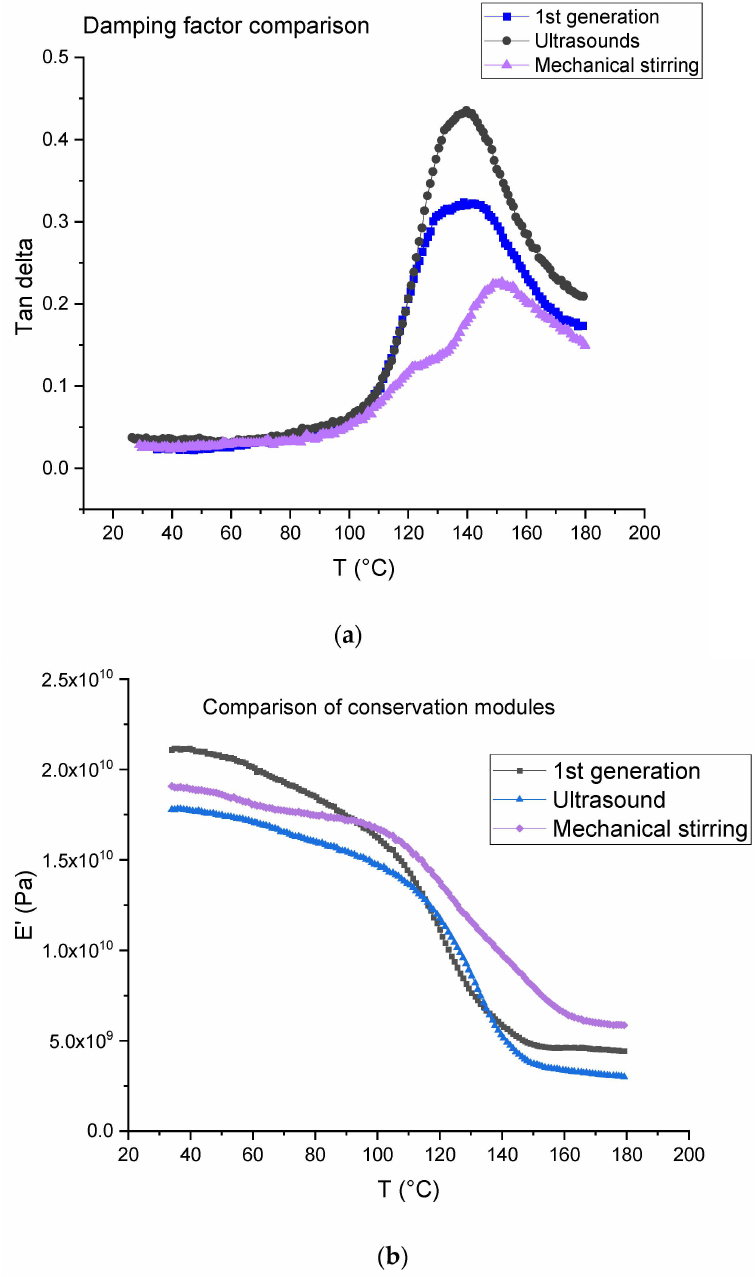
Figure 16. ( a ) Tangent delta; ( b ) conservation modulus of first-generation composites and second- generation composites obtained after dissolution using mechanical stirring and